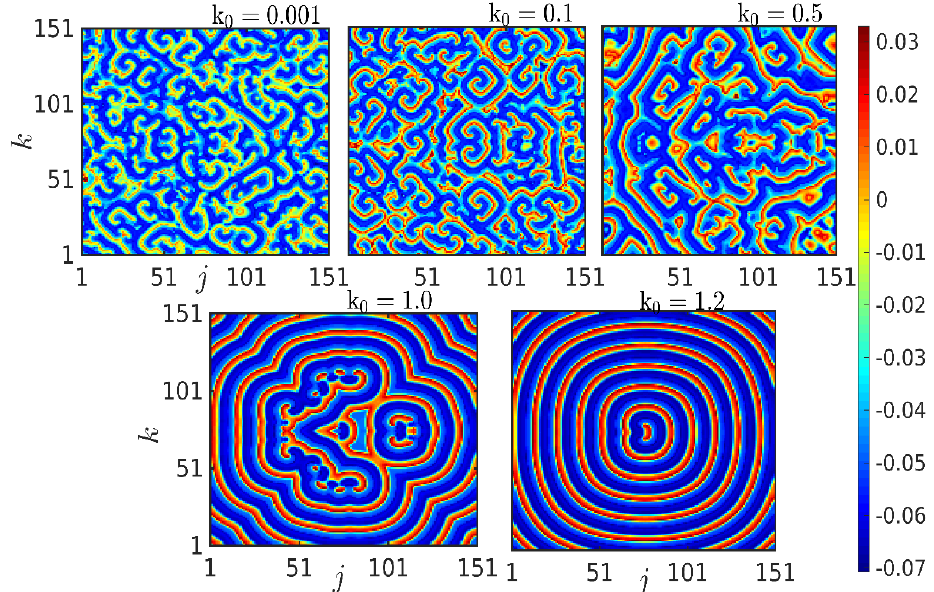
Figure 8. Spiral wave pattern formation and transition to traveling plane wave without external stimulus while increasing flux coupling coefficient as k 0 = 0.001, k 0 = 0.1, k 0 = 0.5, k 0 = 1.0, and k 0 = 1.2. The other parameter values were fixed as specified in Section 2.